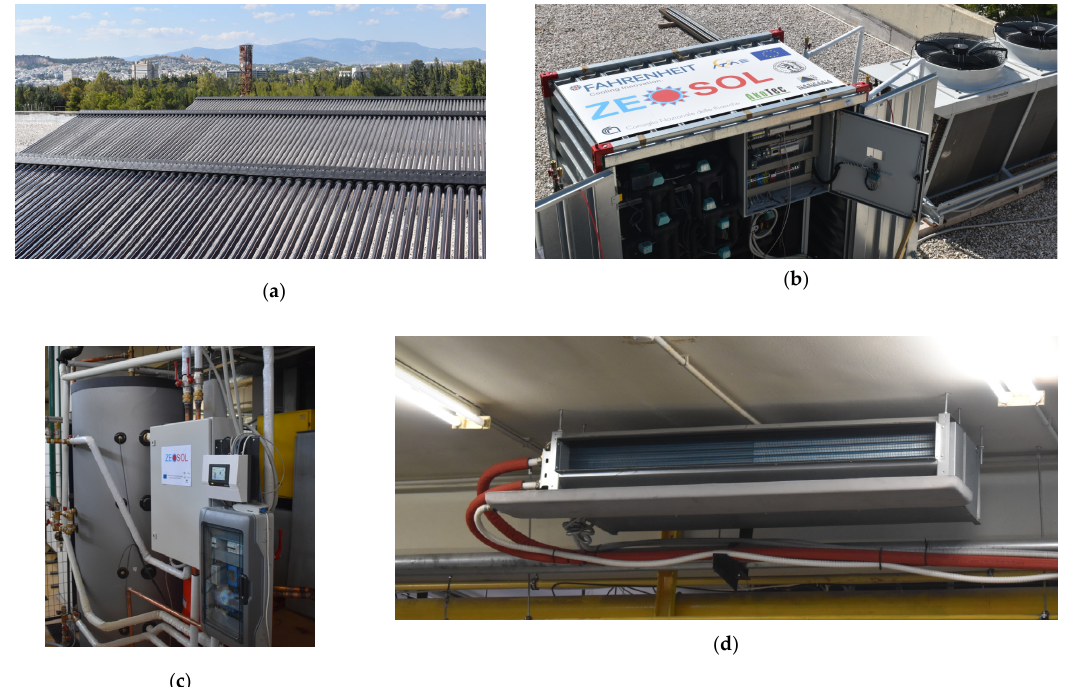
Figure 3. Overview of the experimental set-up components [35]: ( a ) the ETCs (Evacuated Tubes Collectors) solar field; ( b ) the hybrid chiller–dry cooler set-up; ( c ) the solar station and the storage tank and ( d ) the hydronic ducted fan coil unit.